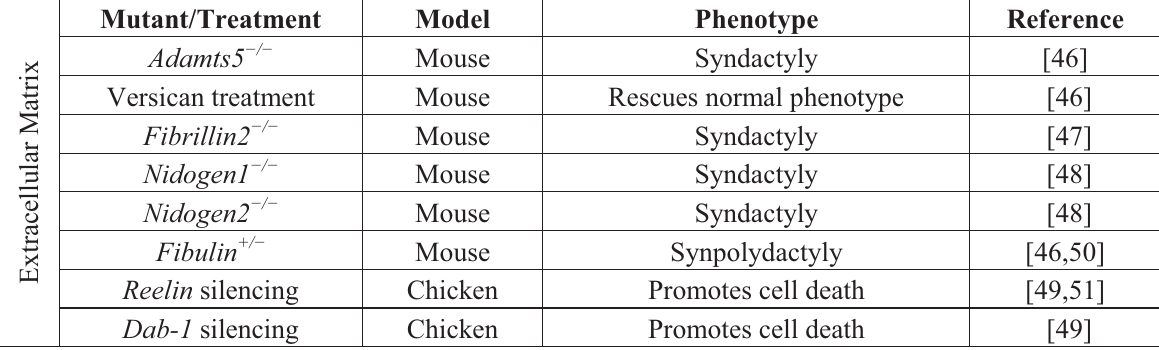
Table 2. Phenotypes observed in mutant mice for genes related to Extracellular Matrix or in embryonic chick limbs treated with RNAi of Reelin or Dab -1 (see text for details).